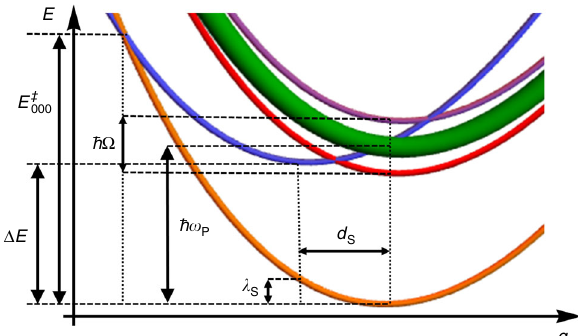
Fig. 3 Potential energy surfaces under VSC along the slow coordinate. (Not to scale.) With respect to the reactant (blue), the vibrational ground state of the product (orange) is in the Marcus inverted regime; the manifold of states with one vibrational excitation (green, red, and purple) in the product is in the normal regime. Although the dark states (green) outnumber the lower (red) and upper (purple) polaritons, the small activation energy associated with the lower polariton channel might make it the preferred pathway